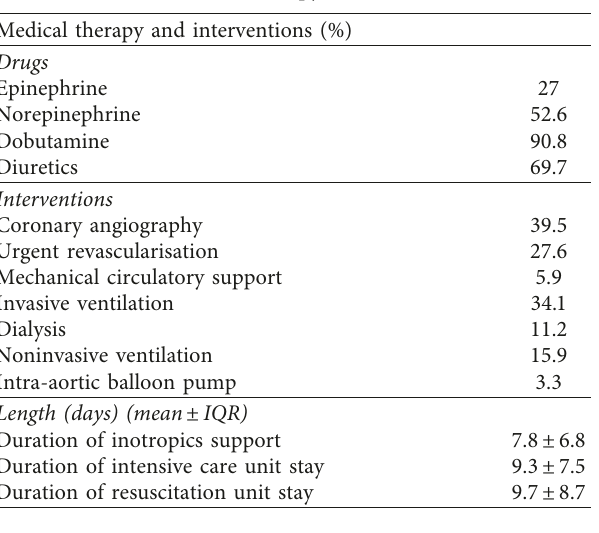
Table 2: Medical therapy and interventions.